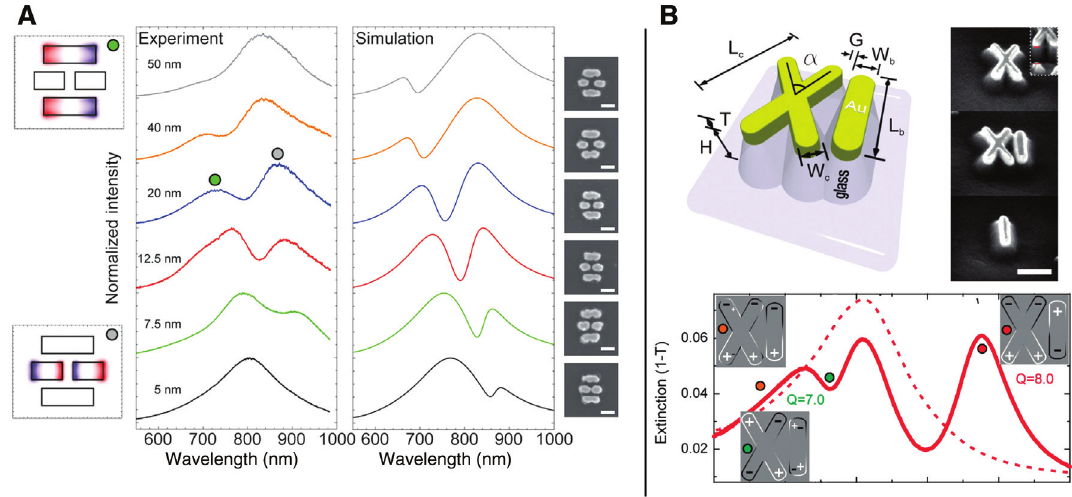
Figure 3: Different types of Fano profiles resulting from the interference between localized plasmon modes supported by two plasmonic systems. (A) The Fano profile appears when two bright modes interfer; (B) interference of a sharp dark mode supported by the X-shaped nanoparticle and the dipolar longitudinal bright mode supported by the nanobar. Indicated are the quality factors of the two reso- nances, much larger for the dark mode. The dashed line represents the superradiant envelop of the mode resulting from the antibonding combination of the dipolar modes associated to the cross and the nanobar. Reprinted with permission from ACS Nano, 2013, 7 (5), pp 4527–36. Copyright 2013 American Chemical